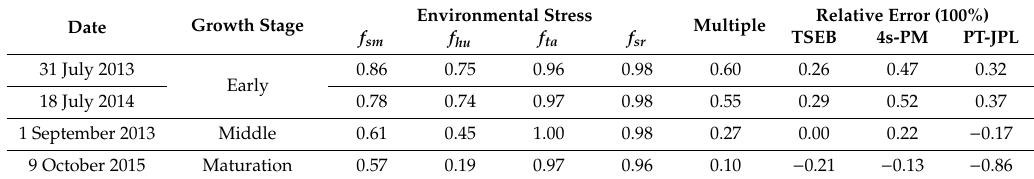
Table 4. Environmental stress and LE estimation relative percentage errors for maize.